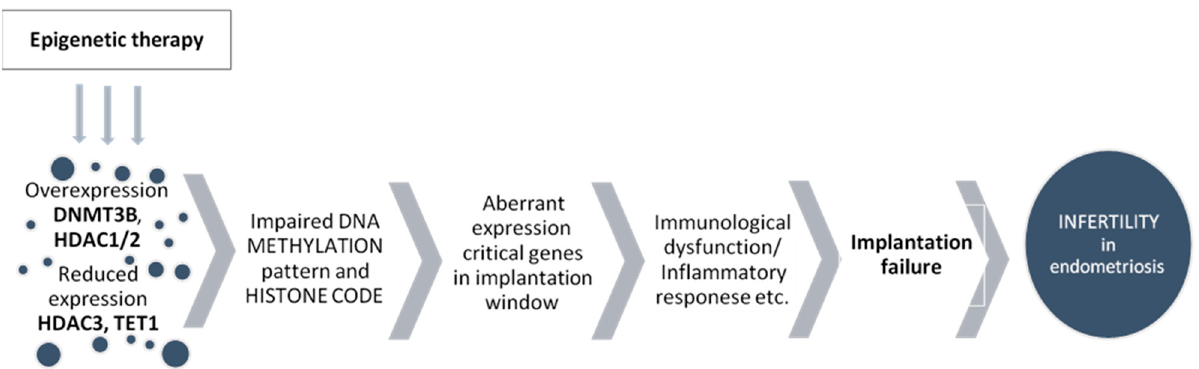
Figure 1. The epigenetic background of implantation failures in the pathogenesis of endometriosis- related infertility. Targets of epigenetic therapy in infertile women with endometriosis. DNMT— DNA methyltransferase, HDAC—histone deacetylase, TET1—ten-eleven-translocation 1 protein.